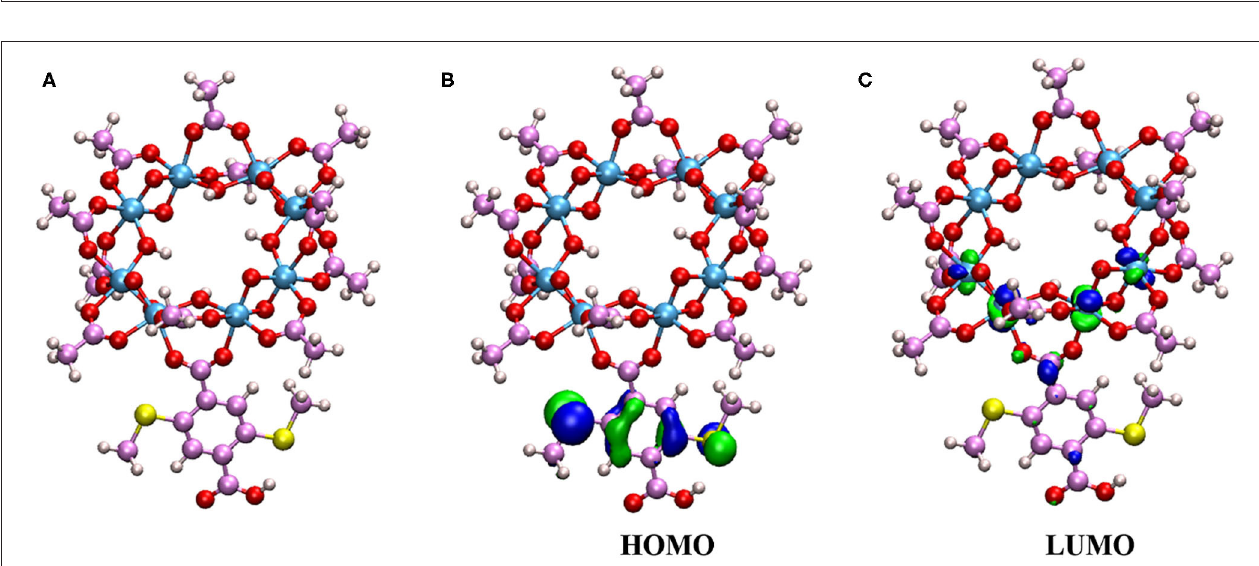
( Figure 5 ) that there are three Pt atoms that interacted with the surface, two of which have partial positive charges. Based on the above discussion, we then speculate that the Pt 13 cluster with a net positive charge might have similar effects with Pt atoms in the system of Pt n + -TiO 2 ( n = 0, 2, or 3). In other words, due to the accumulation of some positive charges on Pt 13